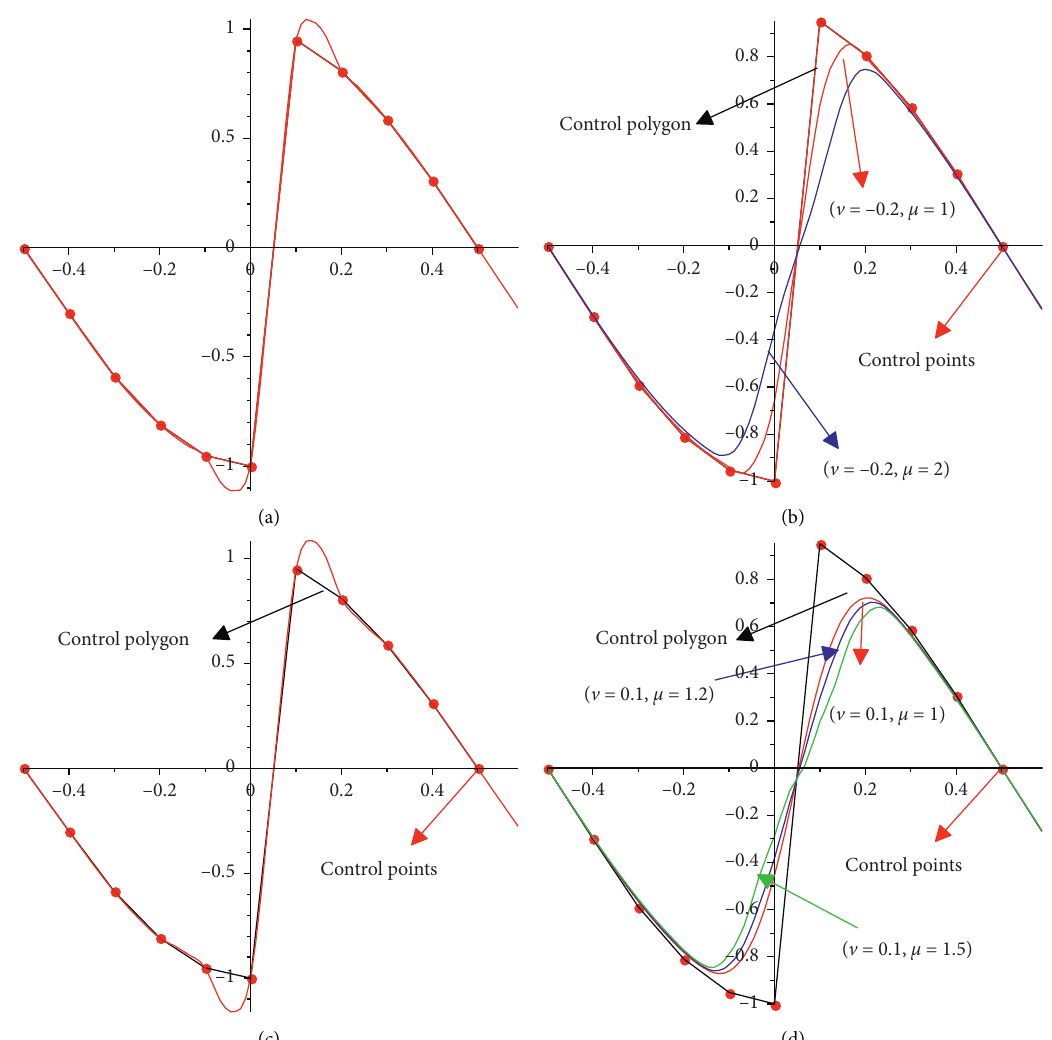
Figure 5: Red bullets are initial control points. Black solid lines are initial control polygons. Coloured lines show the fitted curves by our schemes in (b) and